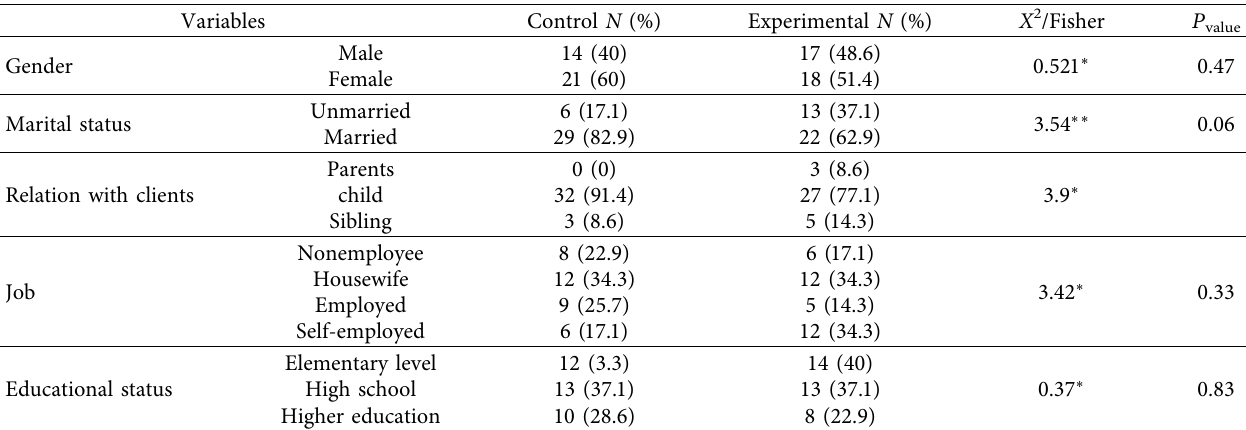
Table 2: Relative and absolute frequency of caregivers of the experimental and control groups based on the